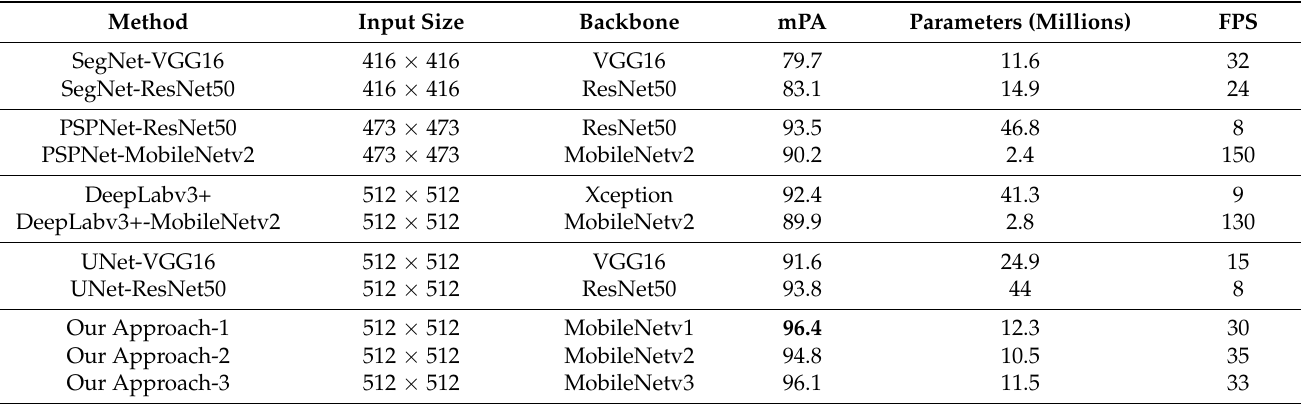
Table 7. Comparison of the quantitative experimental results on the highway driving testing set, where bold numbers indicate the highest mPA in the column.